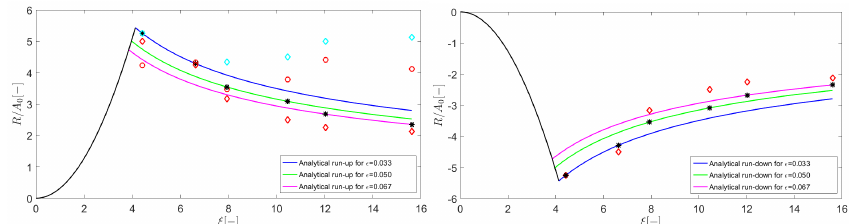
Figure 9. Maximum run-up ( left ) and maximum run-down ( right ) of long sinusoidal waves. Analytical (black stars), experimental (red circles) and numerical (diamonds)—with experimental (cyan) and analytical (red) boundary condition. Solid black line according to Equation (7). Colored solid lines are computed according to Equation (6).